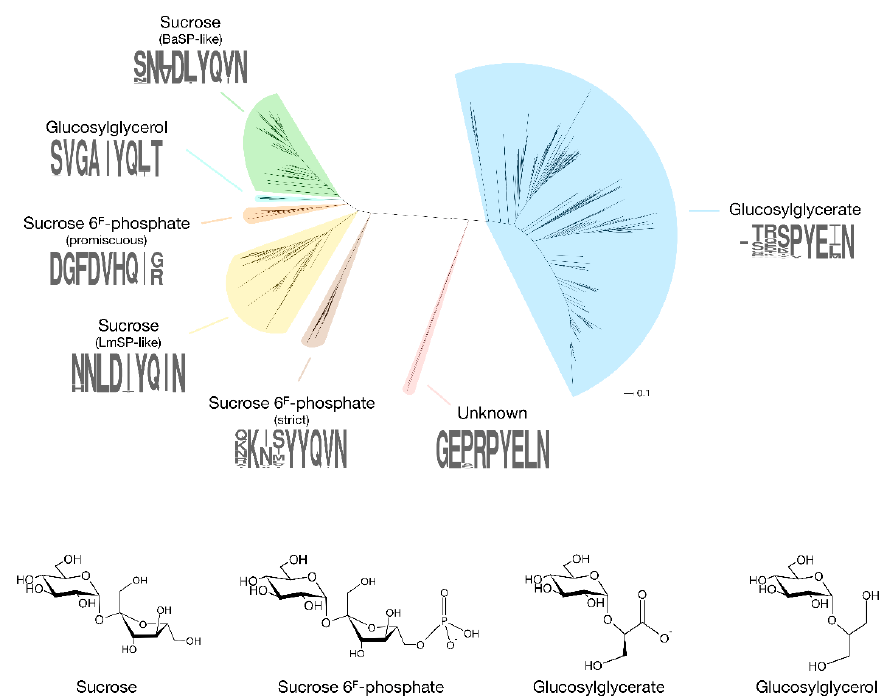
Figure 2. Phylogenetic tree of GH13_18 proteins with the specificities that have been discovered so far (BaSP: Bifidobacterium adolescentis SP; LmSP: Leuconostoc mesenteroides SP). A sequence logo of the loop A region (positions 339–347 in BaSP), which acts as a specificity fingerprint, is shown for each clade. The tree was obtained by extracting all sequences in subfamily GH13_18 from the CAZy database, followed by alignment with ClustalO and tree construction with PhyML 3.1 using default parameters